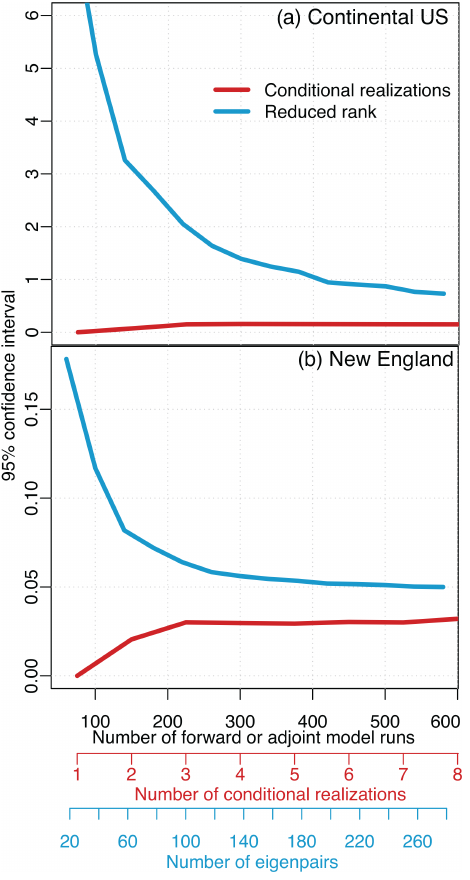
Figure 4. Estimated uncertainties using conditional realizations and the reduced-rank approach for the 6-week case study. Panel (a) shows the estimated uncertainty in the total estimated CO 2 flux for the US and panel (b) for New England. Both approaches converge on the direct estimate as the number of realizations and eigenpairs increase. Note that we estimate the uncertainties for each model grid box and each 3h time period, but we report the uncer- tainties for broader aggregate regions in this figure. Most existing GIM studies report the uncertainties for large regions because these regions are either more ecologically or policy relevant than the indi- vidual model grid boxes. Additionally, the uncertainties are almost always smaller proportional to the total flux for large regions than for individual grid boxes; atmospheric observations usually provide a much more robust constraint on regional flux totals than for indi- vidual model grid boxes.